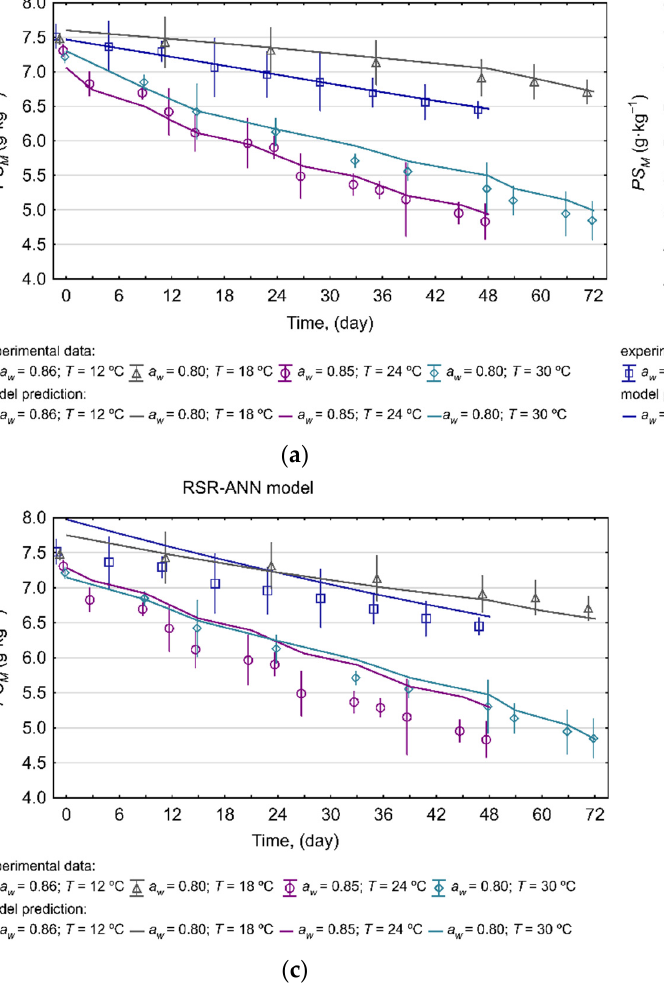
Figure 5. The comparison of ( a ) MLP-ANN, ( b ) RBF-ANN, ( c ) RSR model predictions ( PS M , lines) and observed phytosterol levels ( PS E , points) in rapeseed ecosystems adopted from Wawrzyniak et al. [7] for validation data set.